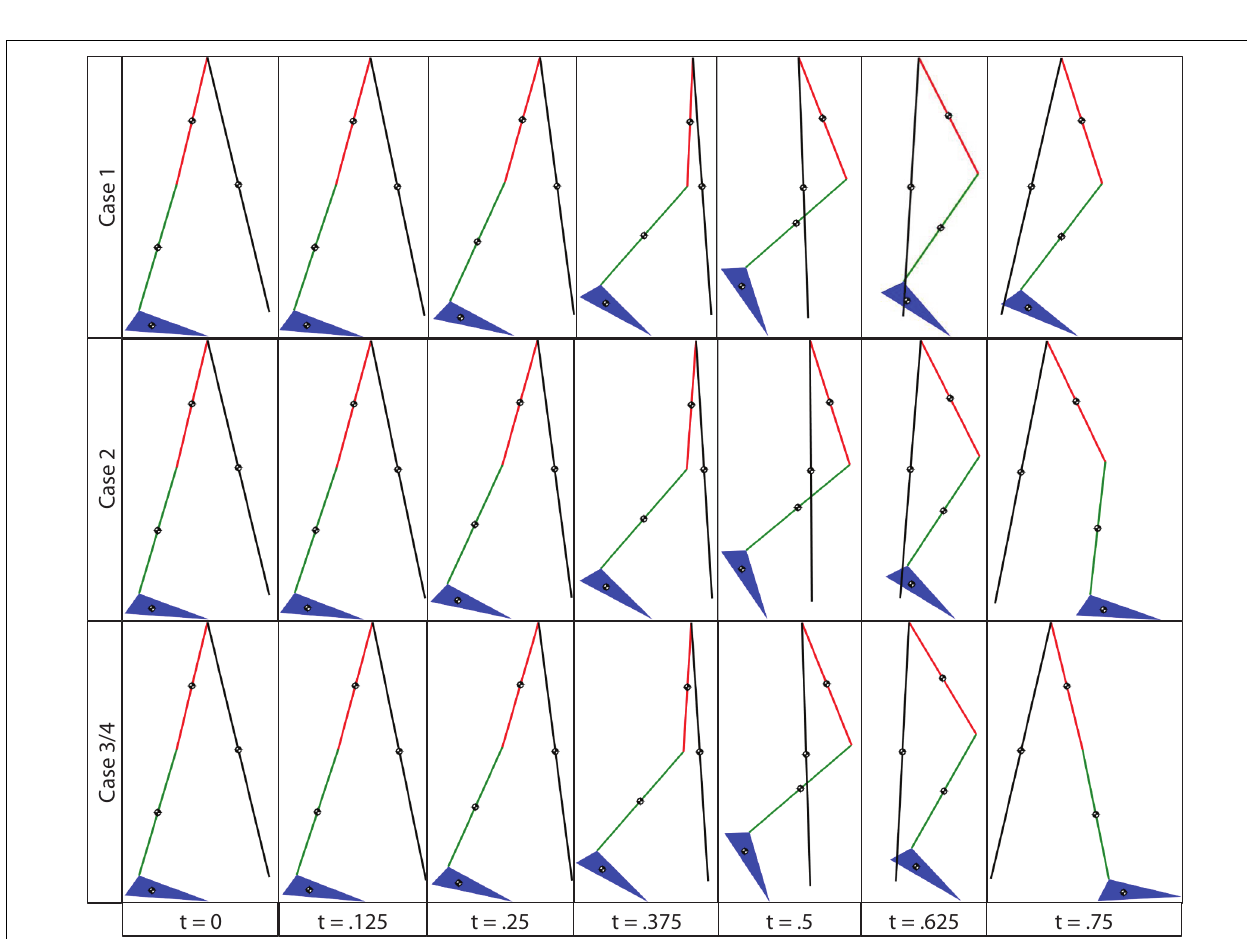
FIGURE 10 | The gait sequence for the four cases, a step length of 0.4m with a step duration of 0.75s was used . Since the errors for the third and fourth cases are so close their gait sequences look identical.